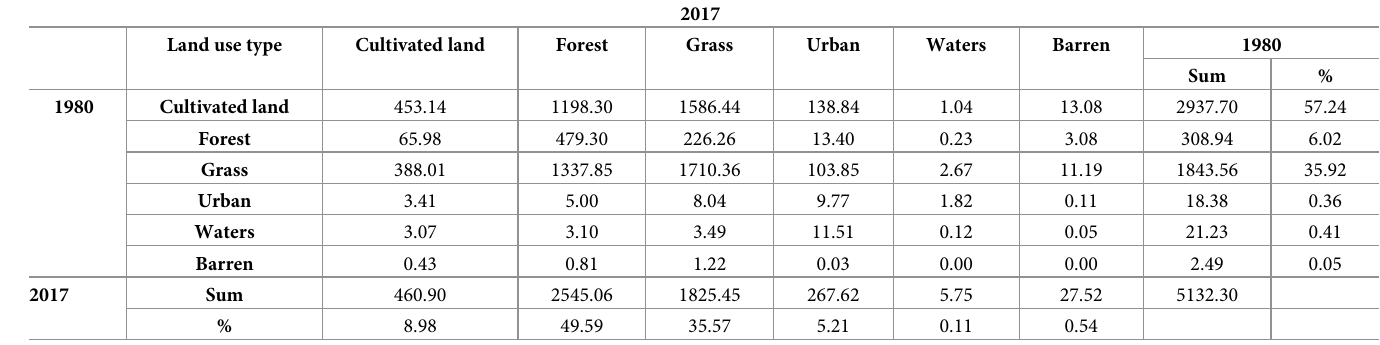
Table 2. Transition matrix of land use conversions (km 2 ) from 1980 to 2017.